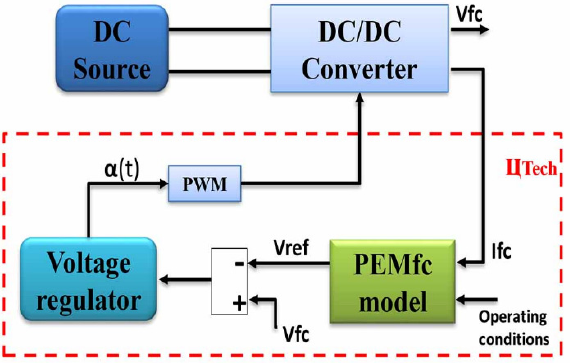
Figure 10. Architecture of PEMFC emulator.